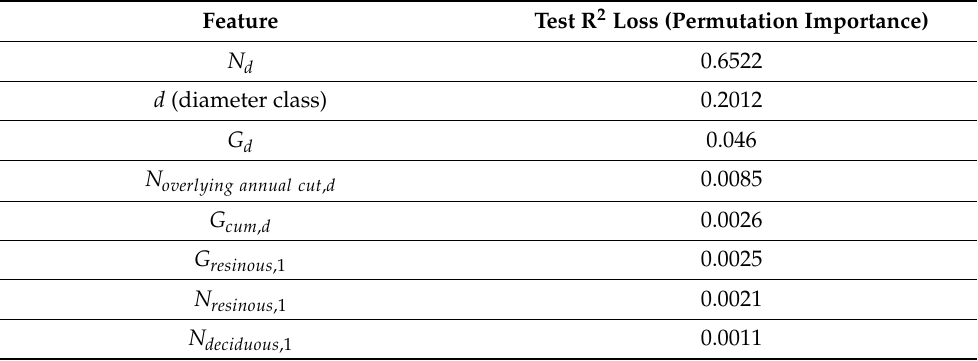
Table 4. Results of a permutation importance procedure on the multilayer perceptron (with 30 repeti- tions). Only main features for which the loss in test R 2 is above 0.001 are mentioned in the